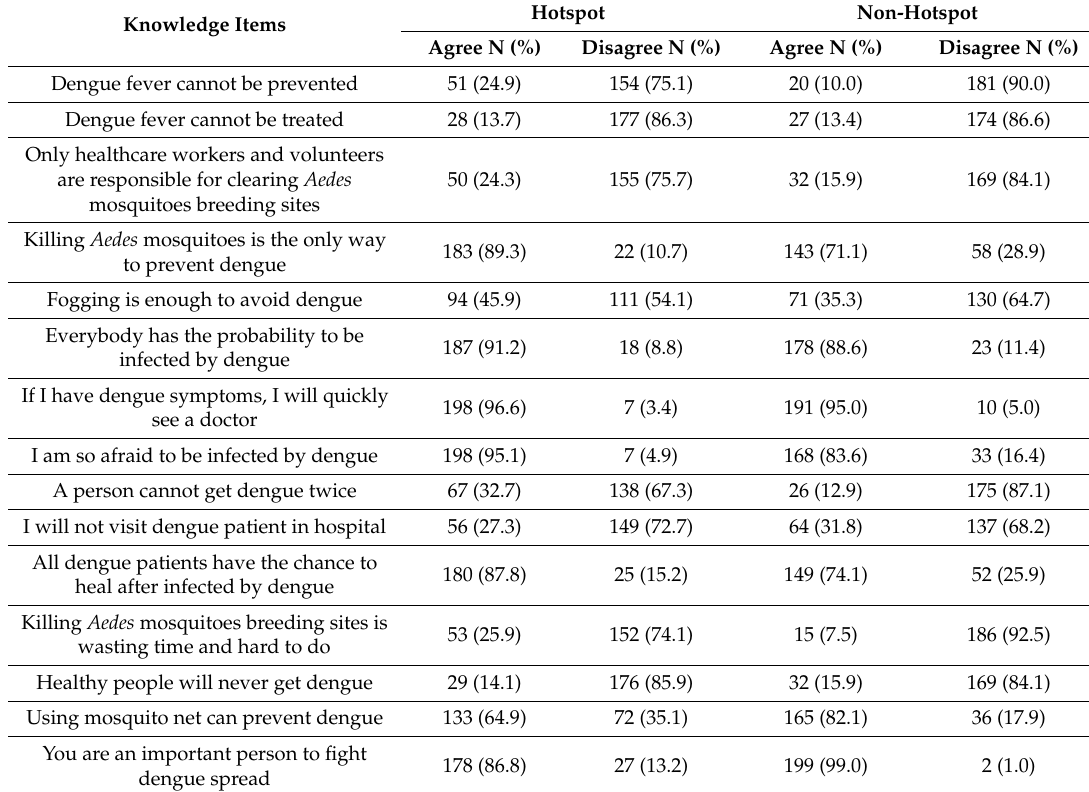
Table 3. Attitude of Respondents’ Towards Dengue